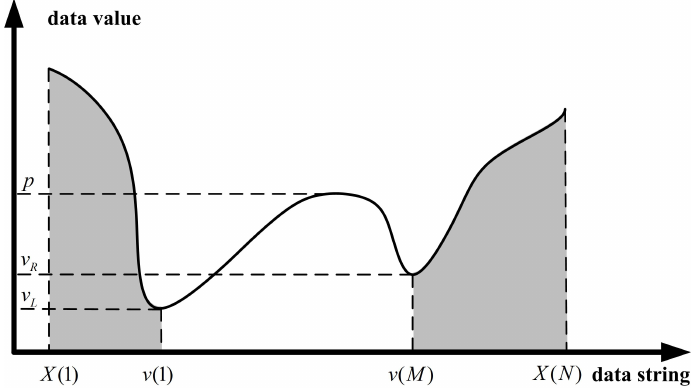
Figure 3. The schematic diagram of the beam characteristics scan